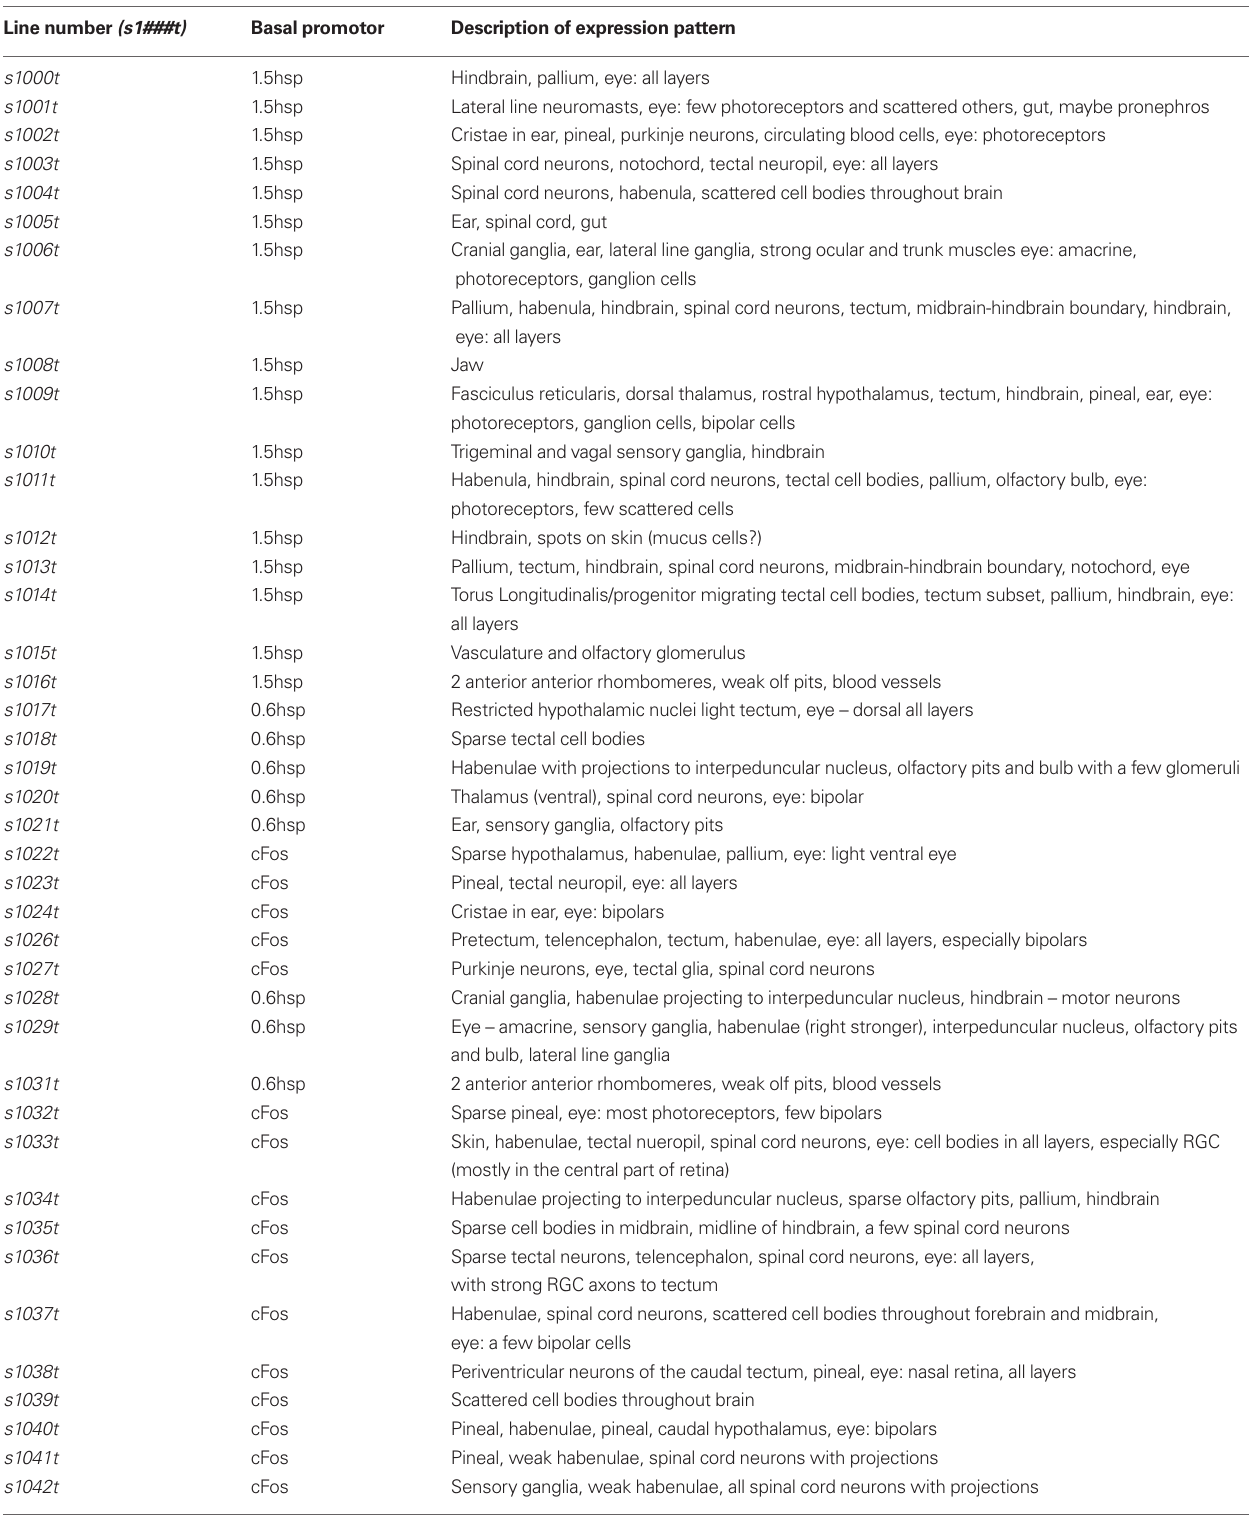
Table  | Brain regions showing expression for each line. For each maintained ET line, the basal promoter used is indicated, and a brief list of the brain regions with expression is